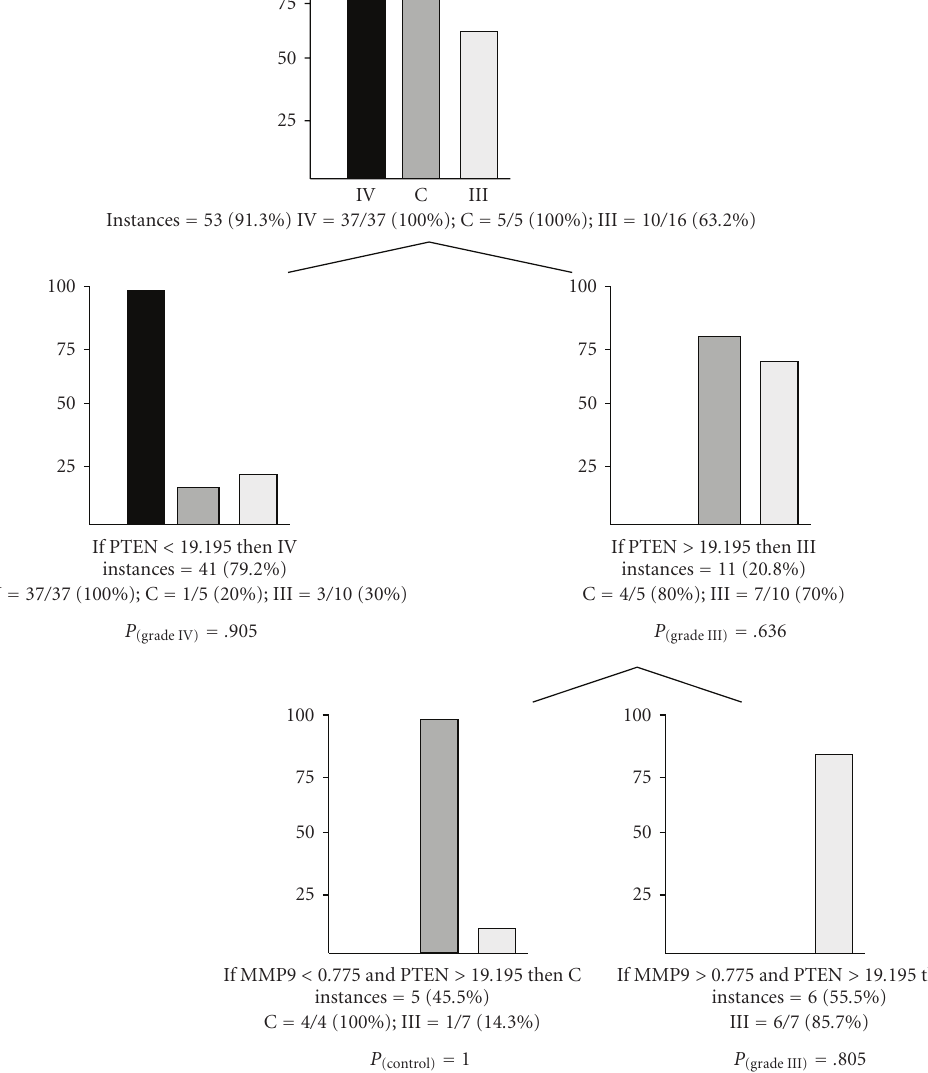
Figure 4: Classification tree derived from the combined measurement of PTEN and MMP9 quantitative expression. At each root, diagnostic classes are divided following the absolute quantification and expressed in femtograms. Probabilities values ( P ) for the di ff erent classes are